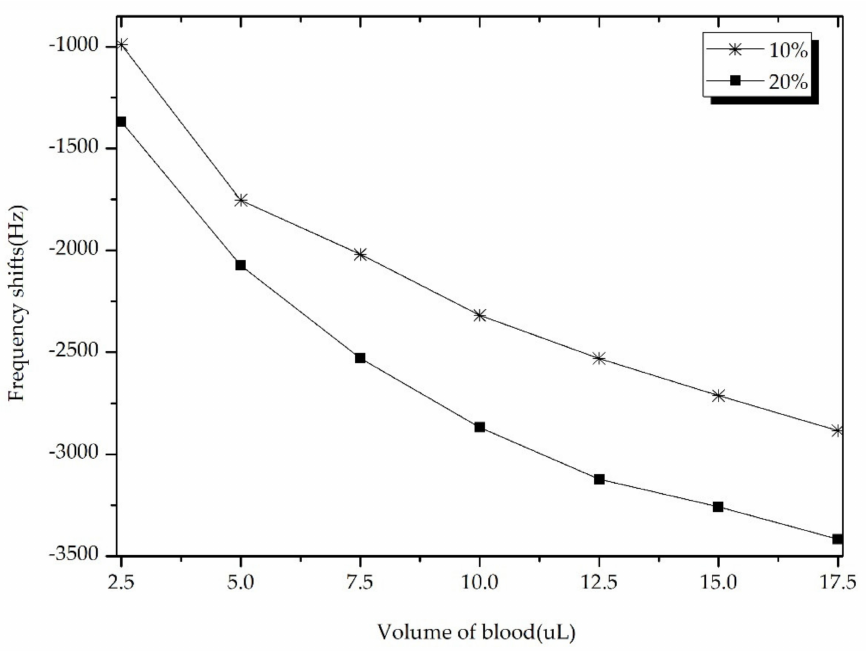
Figure 3. Response of the QCM sensor based on oscillating circuit analysis method.